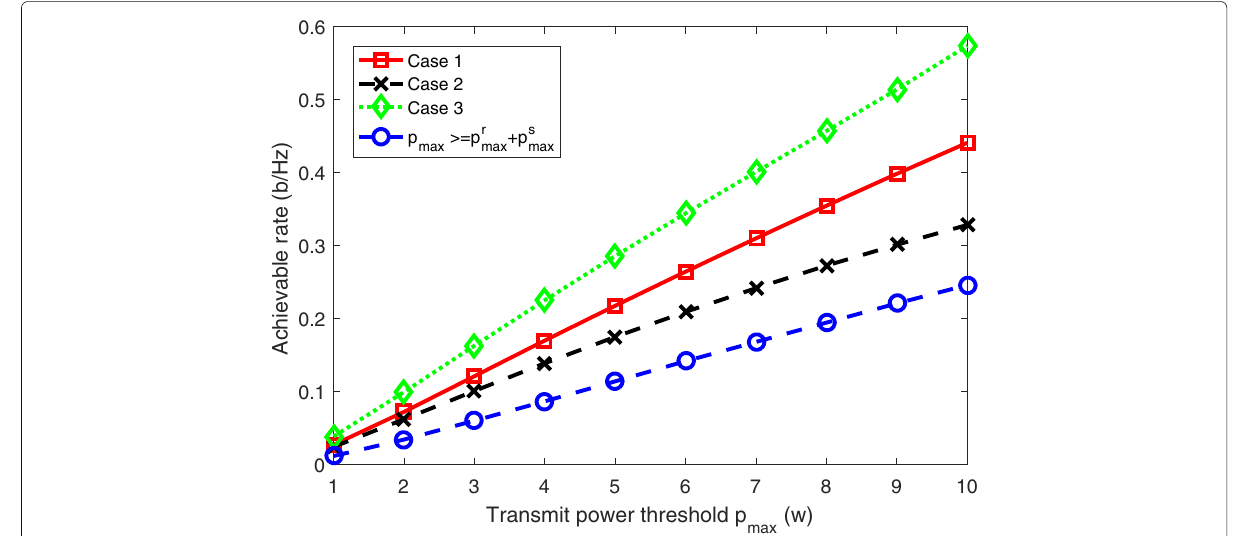
(cid:7) i.e., p max ≥ p s max + p r max